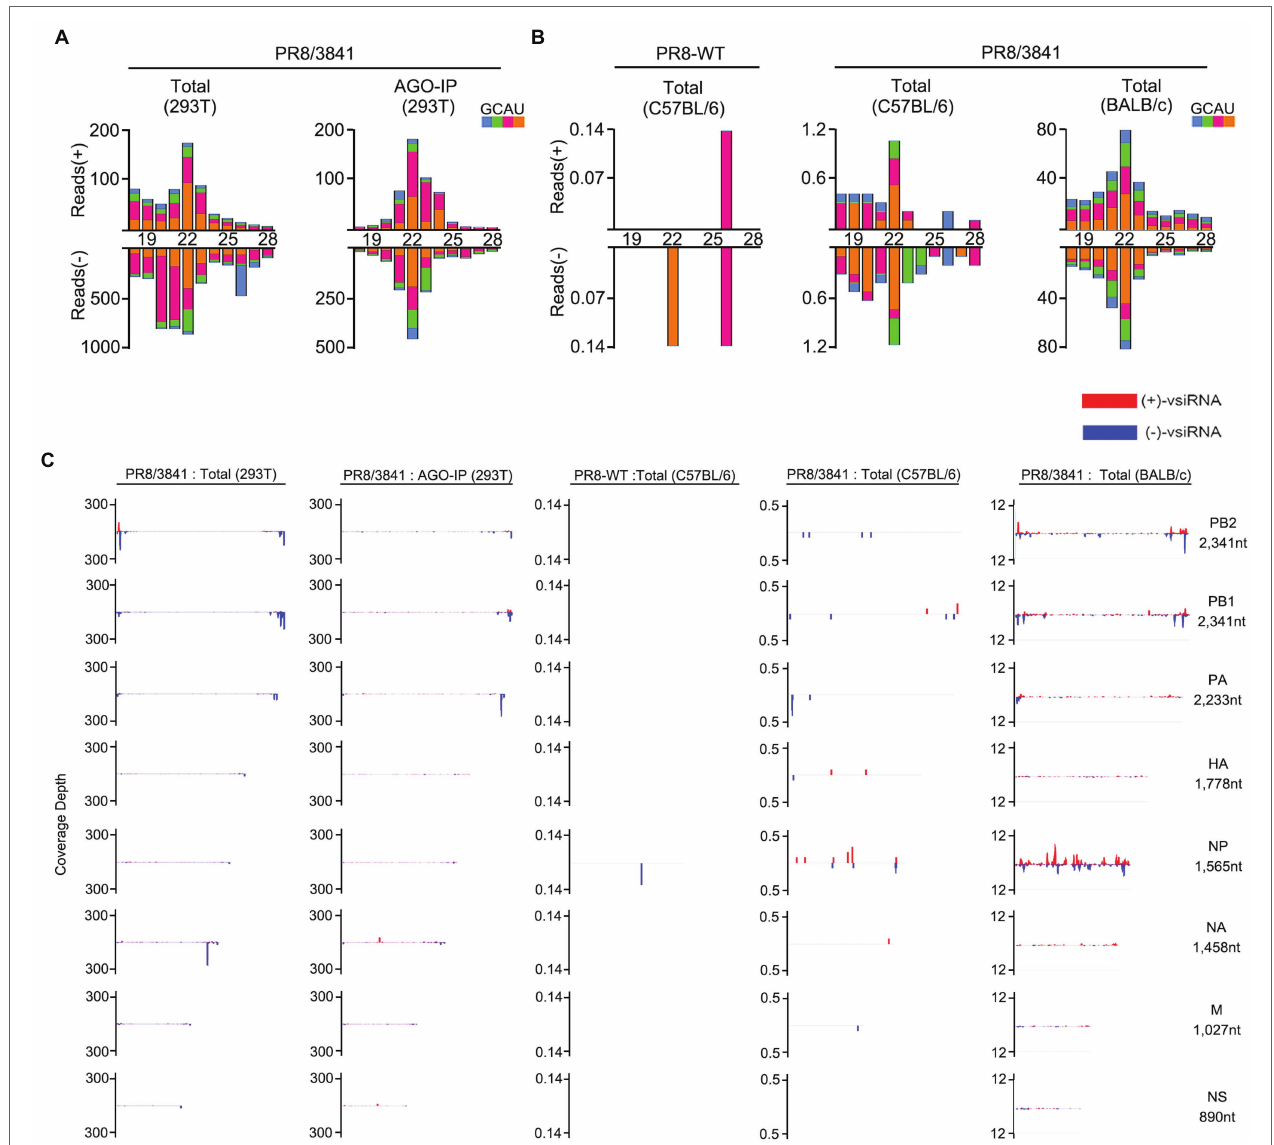
FIGURE 8 | The abundant vsiRNAs produced in mammalian cells and mice with PR8/3841 infection. (A) Properties of vsiRNAs (per million total mature miRNAs) sequenced from 293 T cells without or with AGO-IP (at 1 dpi). Size distribution, abundance, the 5 ′ -nucleotide preference of vsiRNAs (per million total 18–28 nt reads) with PR8/3841 infection. (B) Properties of vsiRNAs (per million total mature miRNAs) sequenced from adult C57BL/6 or BALB/c mice (at 4 dpi) infected with PR8- WT or PR8/3841. Size distribution, abundance, the 5 ′ -nucleotide preference of vsiRNAs (per million total 18–28 nt reads) with PR8-WT or PR8/3841 infection. (C) Relative abundance of 21–23 nt vsiRNA hotspots mapped to PR8-WT or PR8/3841 genomic RNAs, presented from the 3 ′ end to the 5 ′